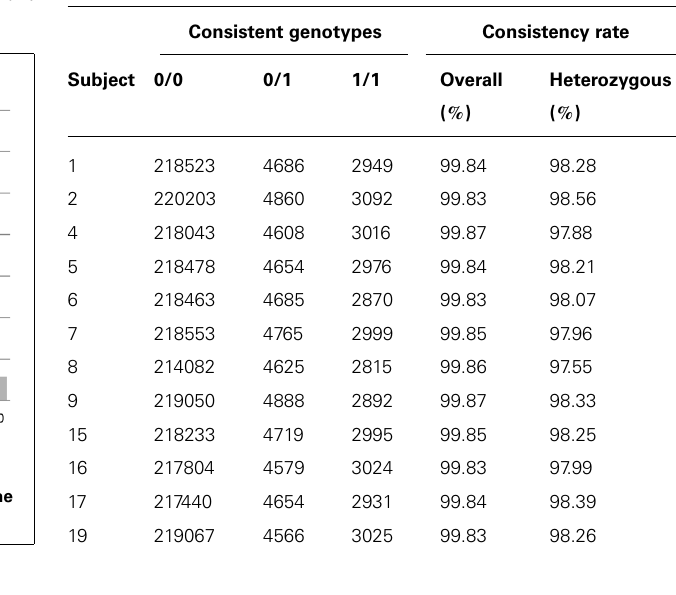
Table 1 | Results of genotype consistency between exome sequencing and exome chip on 12